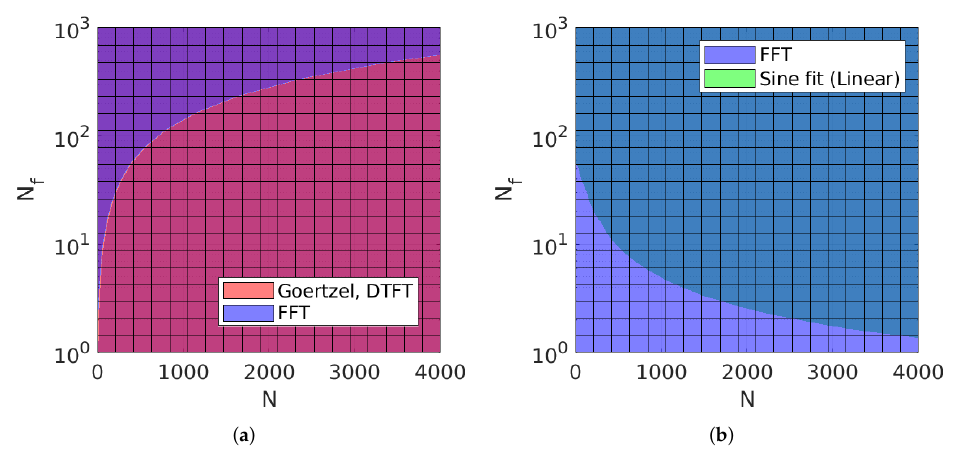
Figure 3. ( a ) Memory usage of DTFT/Goertzel vs. FFT as a function of N and N f . ( b ) Memory usage of Sine-fit (linear) vs. FFT as a function of N and N